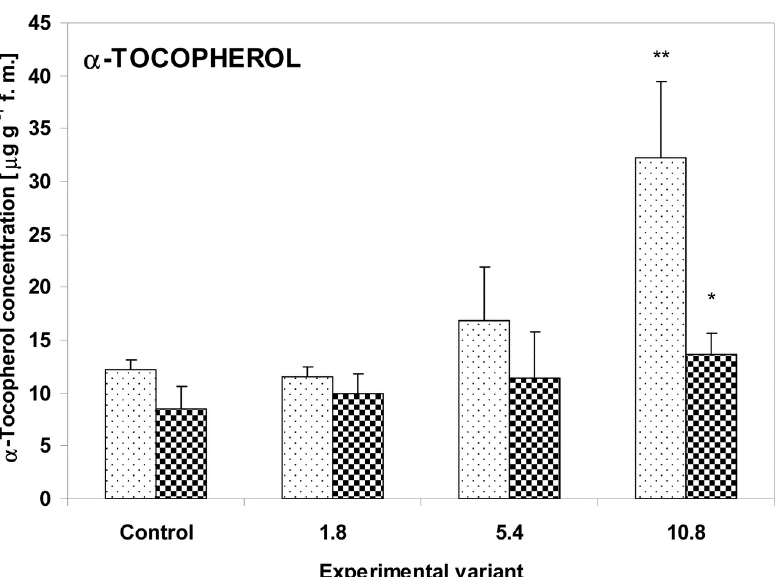
Fig 3. α -Tocopherol concentration in the leaves of zucchini (square without filling) and cucumber (square with dots) grown on the control and sewage sludge amended soil. Concentrations are expressed in μ g g -1 f.m. For further explanation, see Fig 2.